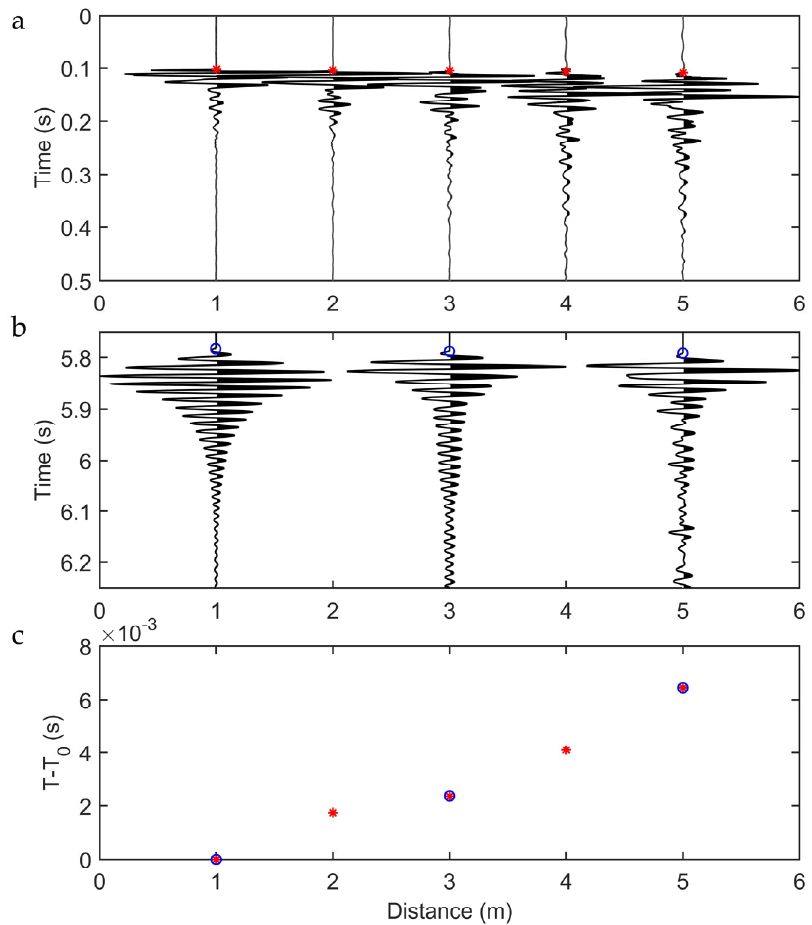
Figure 12. Seismograms of ( a ) standard geophones and ( b ) FBG accelerometer for the external hammer shots, ( c ) first arrival times in terms of delta T in the y -axis with respect to the sensor position of both systems.